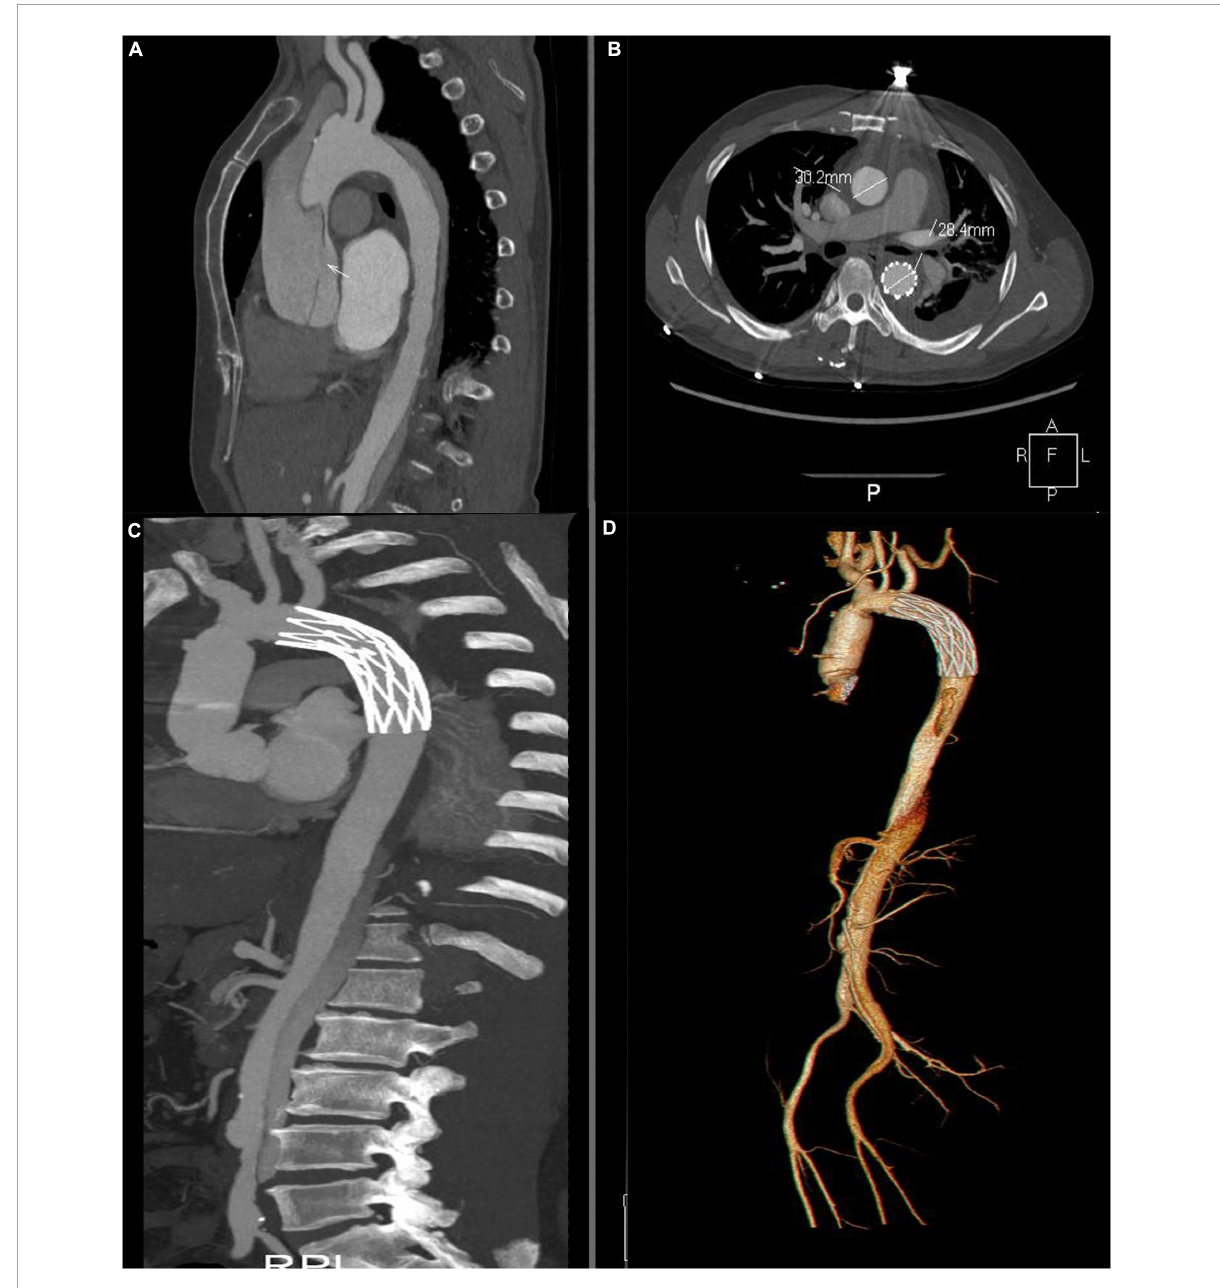
FIGURE4 Computed tomography angiography assessment. (A) Intimal tear in the ascending aortic before the operation. The white arrow indicates the intimal tear. (B) Postoperative examination at 12 month. Thrombosis of the thoracic false lumen in descending aortic. (C,D) Postoperative volume-rendered